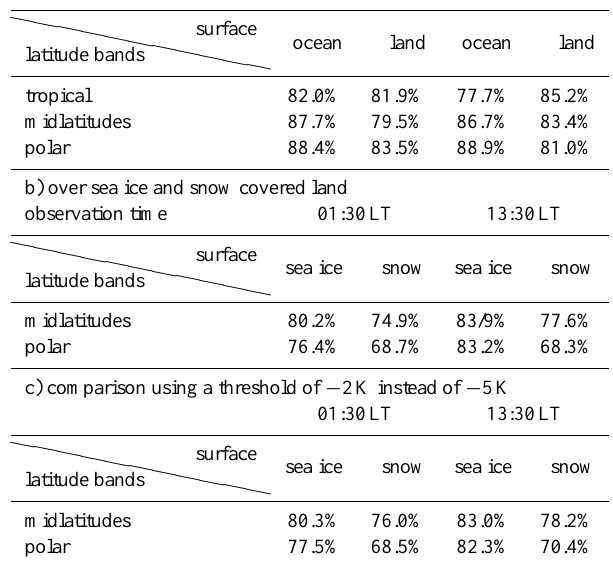
Table 1. Agreement of clear and cloudy scenes determined by the AIRS “a posteriori” cloud detection and by